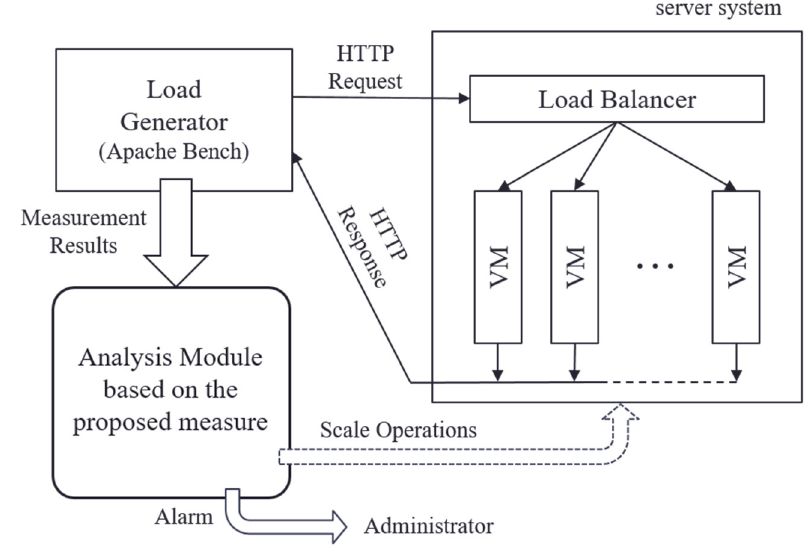
Figure 6. Configuration of the experimental environment.